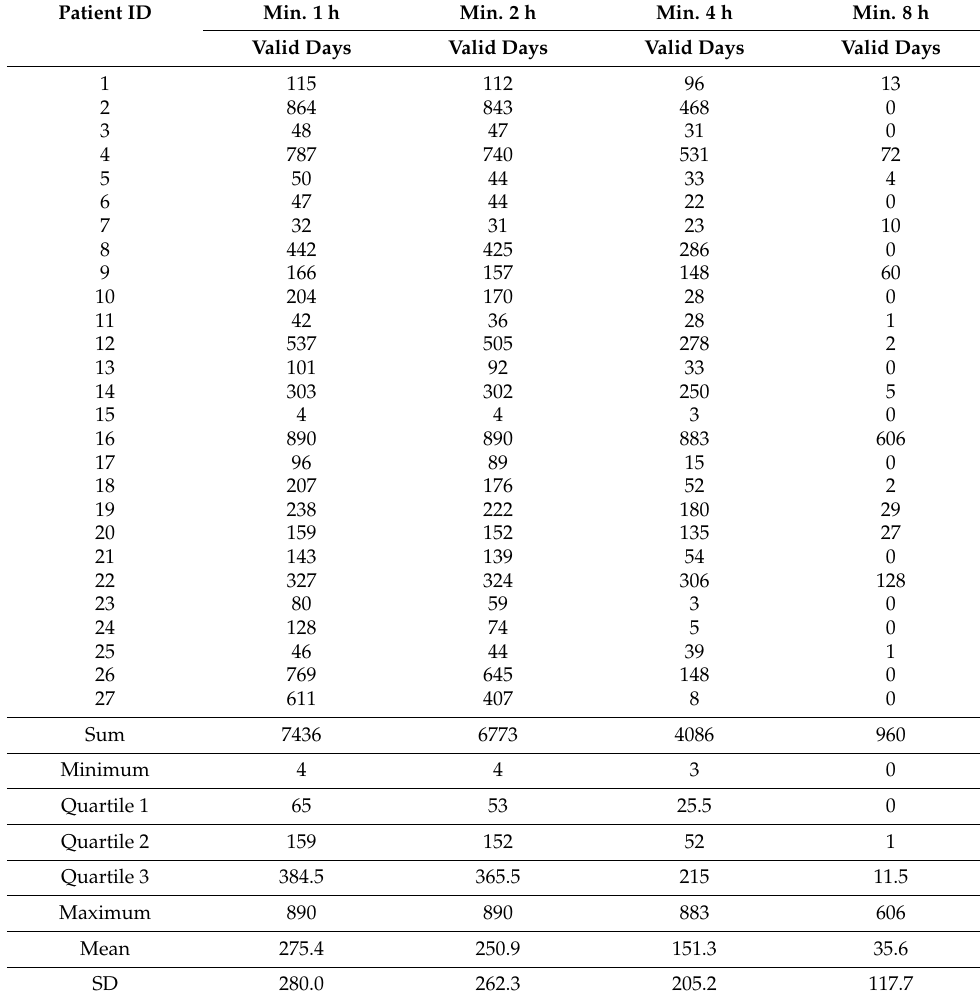
Table A5. Valid Fitbit days for day validation scenario type 3 (27